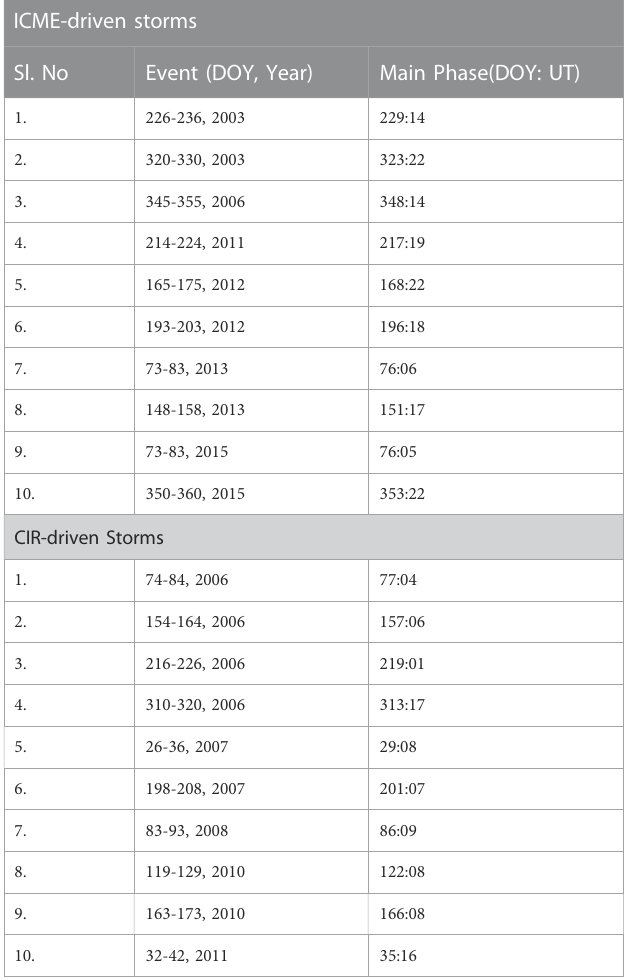
TABLE 1 List of storms used in the present study. ICME-driven storms Sl.